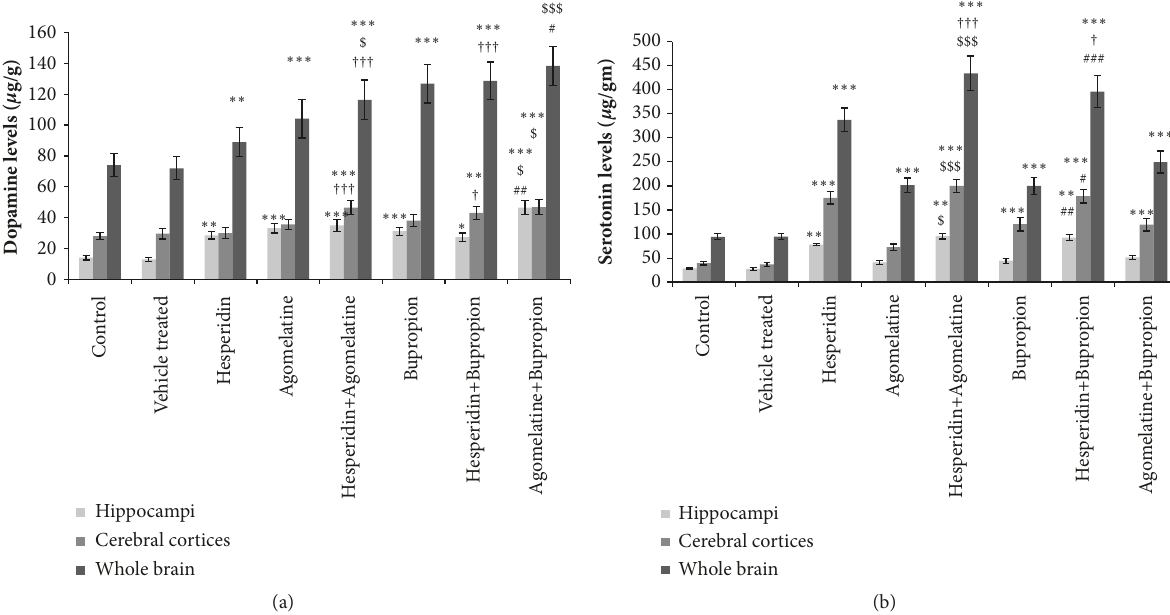
Figure 3: (a) Estimation of dopamine levels in hippocampi, cerebral cortices, and whole brain by HPLC-FD. Significant difference is denoted by ∗ ∗ ∗ P < 0.001 as compared to control group; $$$ P < 0.001 and $$ P < 0.01 as compared to agomelatine treated group; ### P < 0.001 as compared to bupropion treated group; ††† P < 0.001 and †† P < 0.01 as compared to hesperidin treated group. (b) Estimation of serotonin levels in hippocampi, cerebral cortices, and whole brain by HPLC-FD. Significant difference is denoted by ∗ ∗ ∗ P < 0.001 as compared to control group; $$$ P < 0.001, $$ P < 0.01, and $ P < 0.05 as compared to agomelatine treated group; ### P < 0.001 and ## P < 0.01 as compared to bupropion treated group; ††† P < 0.001 as compared to hesperidin treated